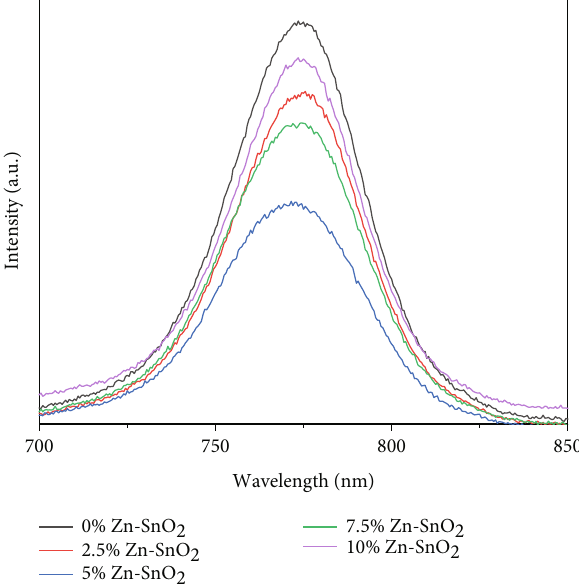
Figure 4: The PL spectra of PSCs with di ff erent doping concentrations of Zn-SnO compact layers. 2